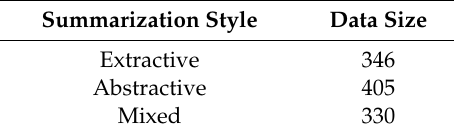
Table 1. Randomly selected paired article-summary dataset from NEWSROOM test data for comparing word embedding based text summarization (WETS) with Lede-3.